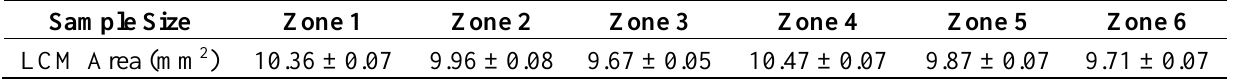
Table 1. Area of brain tissue obtained by laser capture microdissection